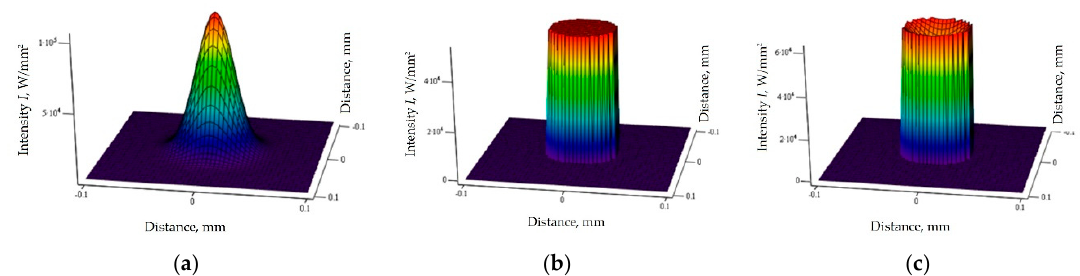
Figure 3. The power density distribution of laser radiation in different planes, near the focal plane of the lens: ( a ) Gauss; ( b ) flat top; ( c ) donut.